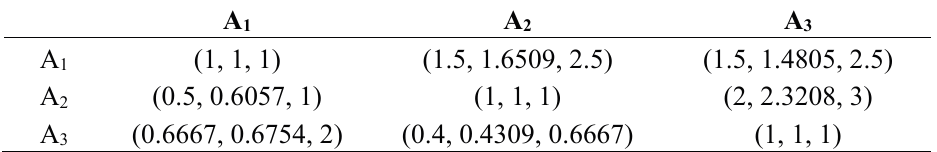
Table 9. The group judgment matrix of the attributes within the “price” criterion.